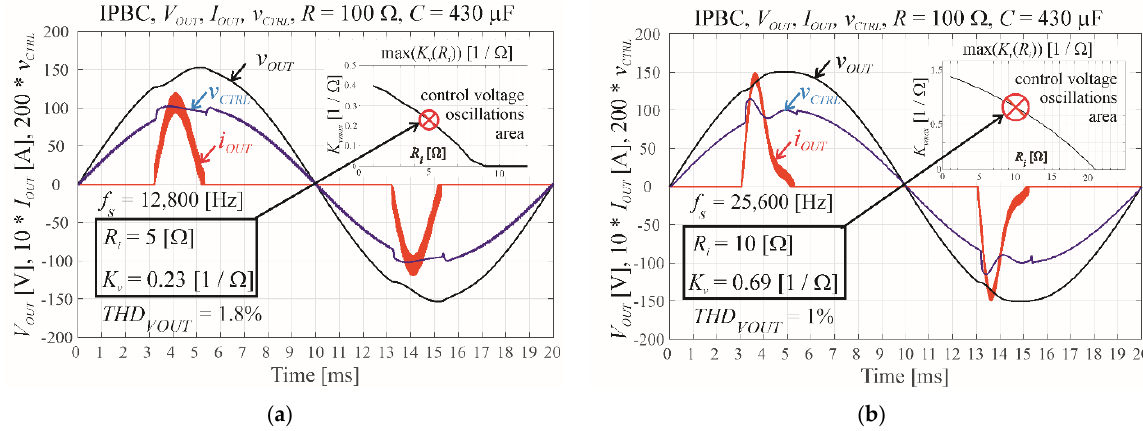
Figure 5. Border values for the rectifier RC load gains ( C F = 50 μ F, L F = 1 mH, R LF = 1 Ω , and M = 0.5, load: R = 100 Ω , C = 430 μ F) for ( a ) f s = 12,800 Hz and ( b ) f s = 25,600 Hz.